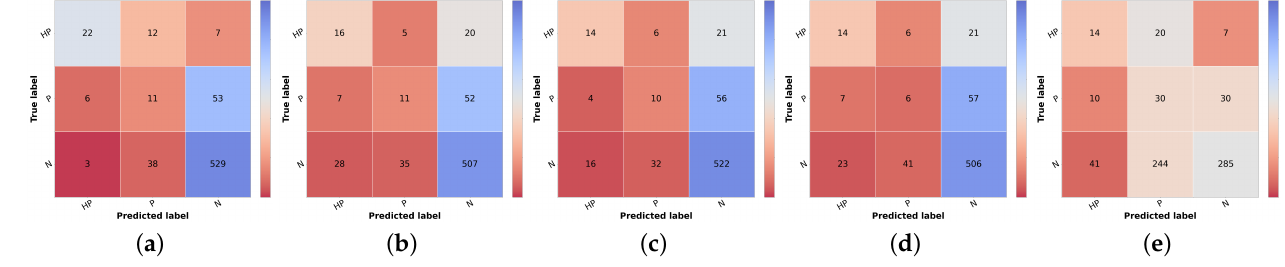
Figure 6. Confusion matrices of test set 1 for the different risk prioritization approaches